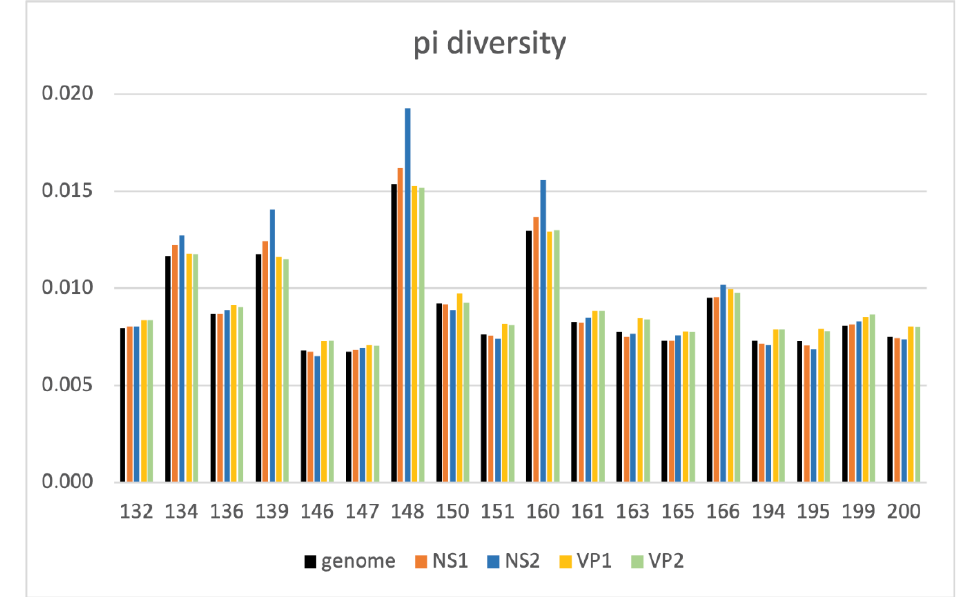
Figure 5. Nucleotide diversity (π) across the whole genome and per gene (NS1, NS2, VP1, and VP2). The whole genome within-sample π diversity varied between 0.7% and 1.5%. Four samples (#134, #139, #148, and #160) had a pi diversity >1%.